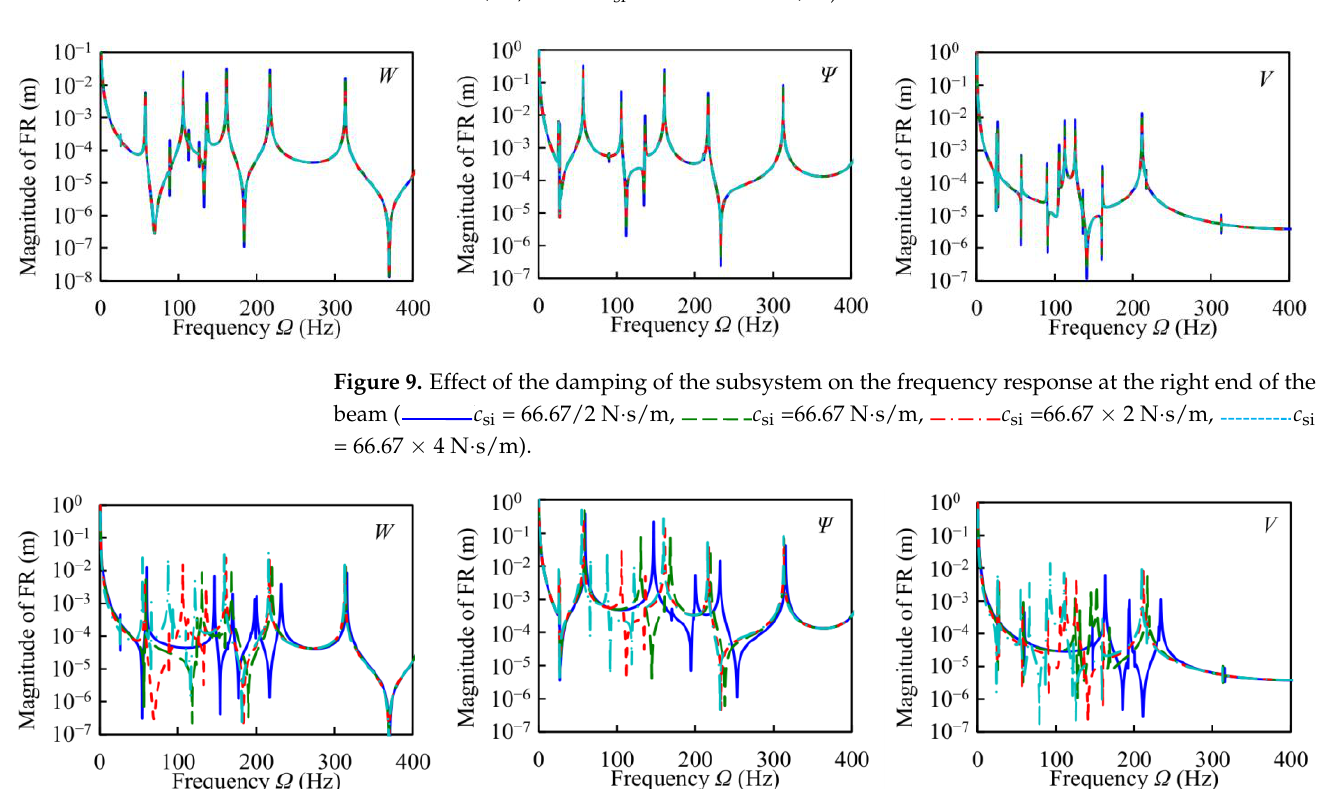
Figure 8. Effect of the stiffness of the subsystem on the frequency response at the right end of the thin-walled beam ( k si = 3333.33/2 kN/m, k si = 3333.33 kN/m, k si = 3333.33 × 2 kN/m, k si =3333.33 × 4 kN/m).